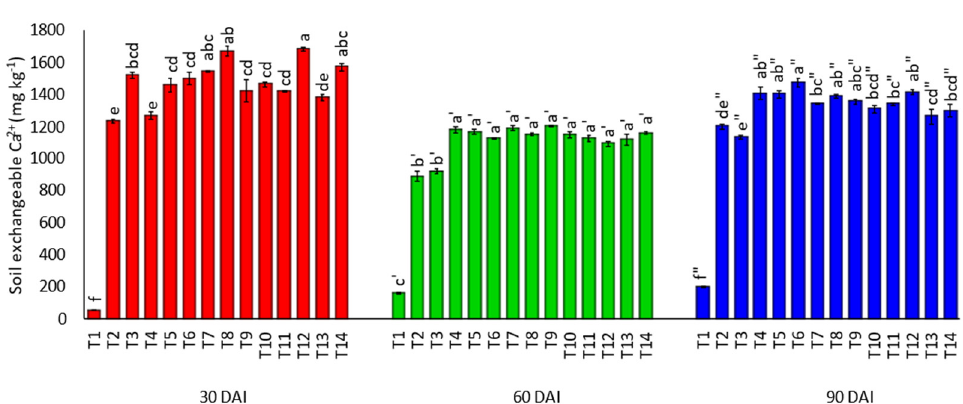
Figure 9. Effects of treatments on soil exchangeable potassium ions after thirty, sixty, and ninety days of incubation, where T1: soil alone, T2: Egypt rock phosphate alone, T3: Egypt rock phosphate + 100% charcoal, T4: Egypt rock phosphate + 100% sago bark ash, and T5: Egypt rock phosphate + 100% charcoal + 100% sago bark ash, T6: Egypt rock phosphate + 75% charcoal + 75% sago bark ash, T7: Egypt rock phosphate + 50% charcoal + 75% sago bark ash, T8: Egypt rock phosphate + 25% charcoal + 75% sago bark ash, T9: Egypt rock phosphate + 75% charcoal + 50% sago bark ash, T10: Egypt rock phosphate + 50% charcoal + 50% sago bark ash, T11: Egypt rock phosphate + 25% charcoal + 50% sago bark ash, T12: Egypt rock phosphate + 75% charcoal + 25% sago bark ash, T13: Egypt rock phosphate + 50% charcoal + 25% sago bark ash, and T14: Egypt rock phosphate + 25% charcoal + 25% sago bark ash. Means with different letter(s) within the same incubation period indicate significant differences between treatments according to Tukey’s HSD test at p ≤ 0.05, i.e., a > b > c. Bars represent the mean values ± SE.